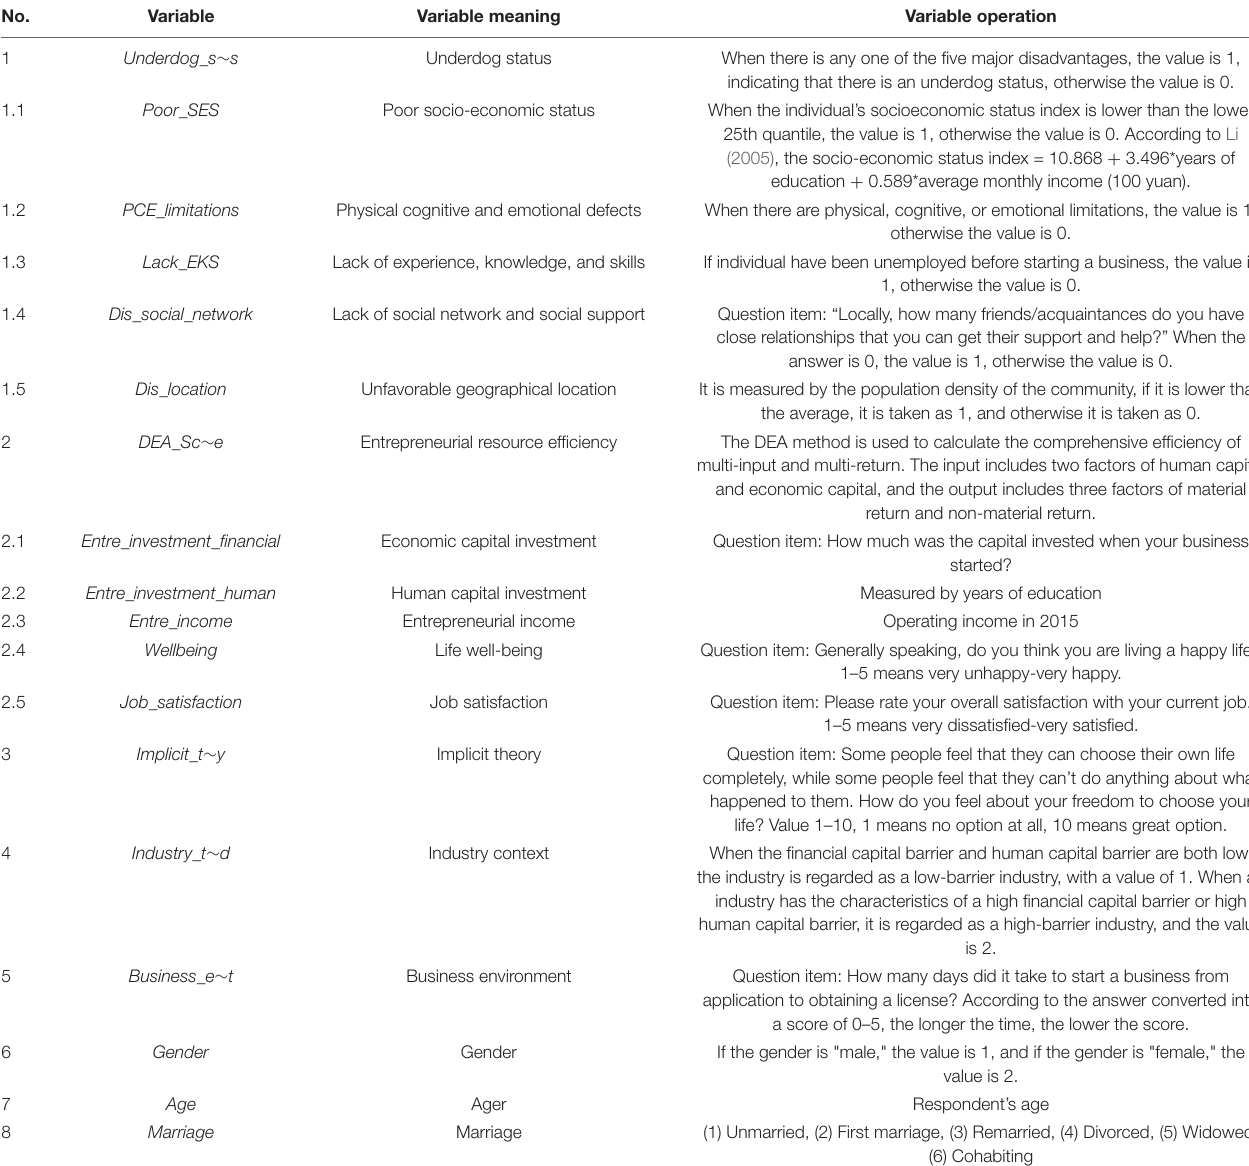
TABLE 1 | Variable measurement design of Study